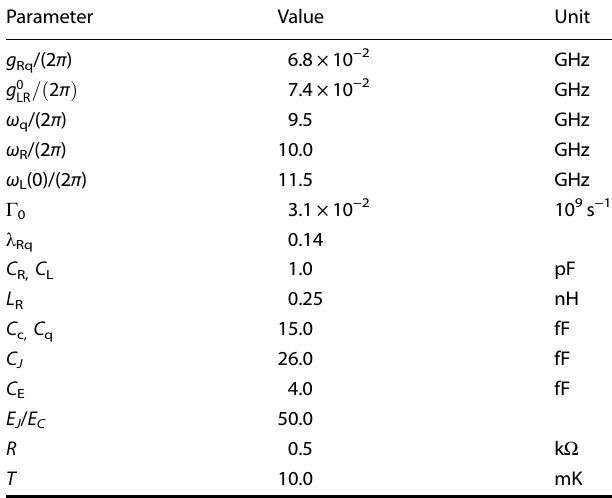
Table 1. Parameters used in the numerical